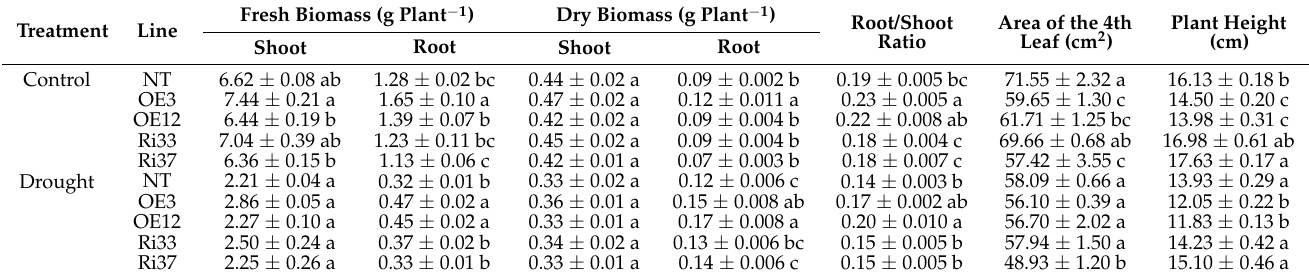
Figure 1. Phenotype of transgenic maize lines under drought stress indoors and changes of the chlorophyll content under PEG treatment. Two CgbHLH001 -overexpressed lines (OE3 and OE12), two ZmbHLH -RNAi lines (Ri33 and Ri37), and non-transgenic plant (NT) were treated under nat- ural drought conditions. ( a ) Control (normally-watered); ( b ) drought (deprived water for 8 days); ( c – e ) Chl a, Chl b, Chl a/b content, respectively; ( f ) SPAD values (relative chlorophyll content mea- sured by soil plant analyzer development on the living plant). NT, non-transgenic plant; OE3 and OE12, CgbHLH001 -overexpressed T 3 maize lines; Ri33 and Ri37, ZmbHLH -RNAi T 3 maize lines. PEG, 15% PEG 6000 (polyethylglycol). Different lowercase letters above the columns indicate significant differences between NT plants and transgenic lines under the same condition (Tukey’s test, p < 0.05). Values are means ± SD of three replicates. Table 1. Growth characterization of transgenic lines and NT under normal and drought